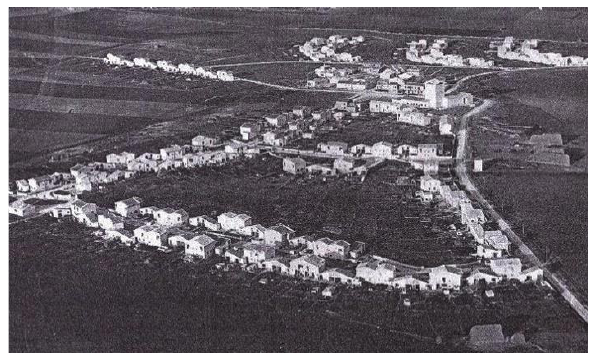
Figure 2. L. Quaroni (group leader), the rural